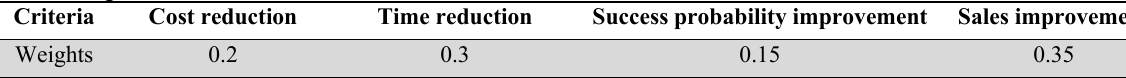
Criteria weights